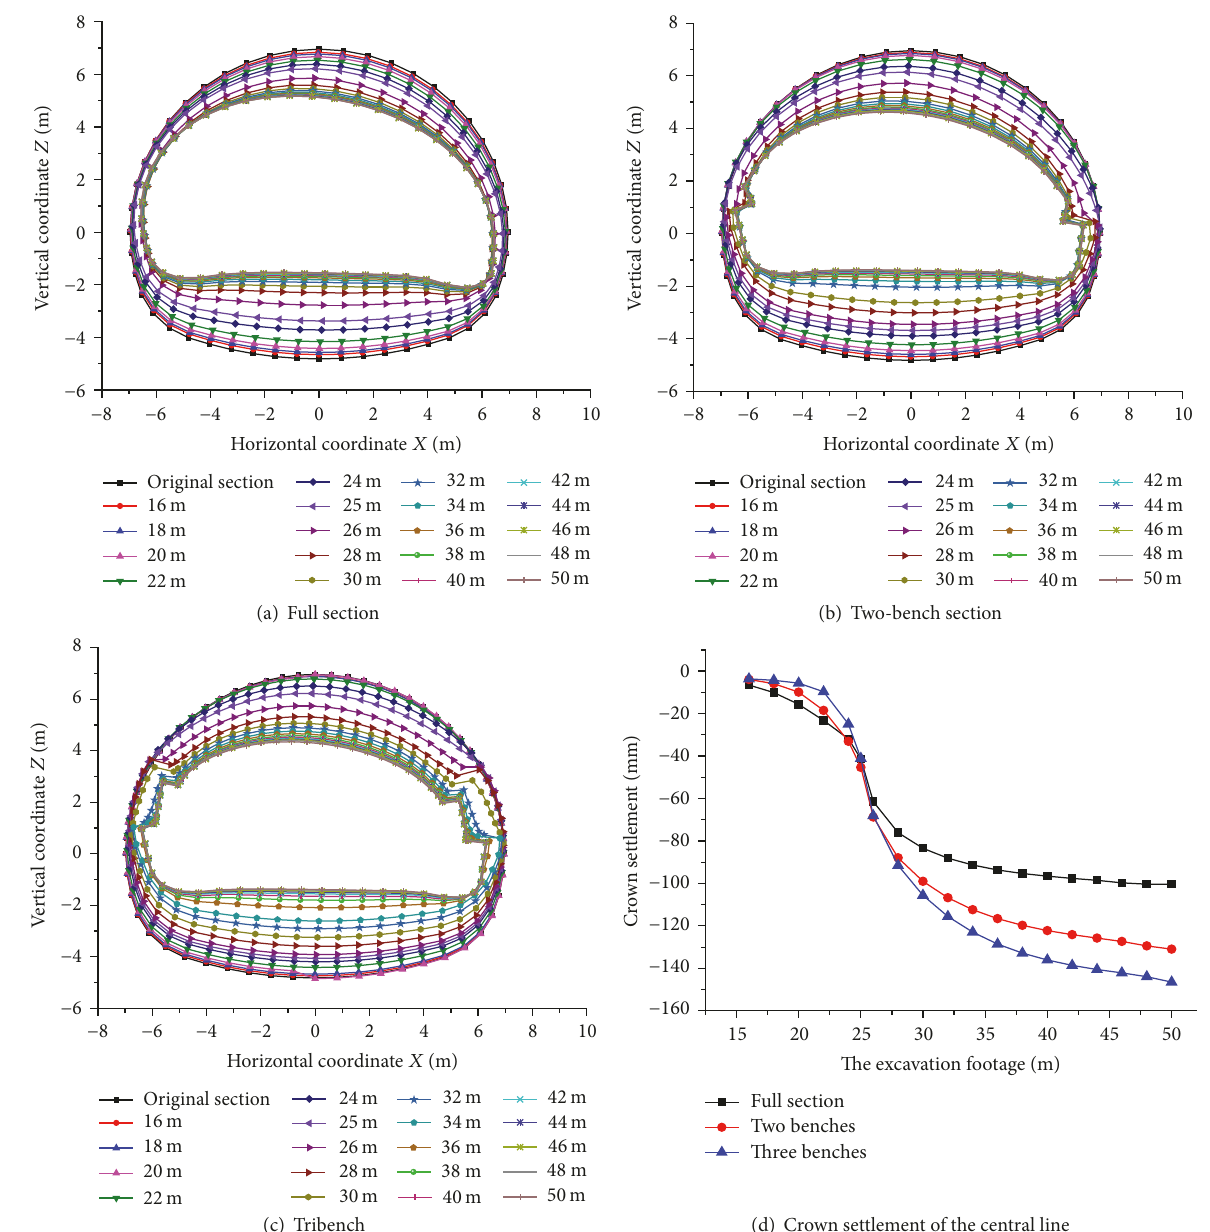
Figure 5: The clearance convergence by different